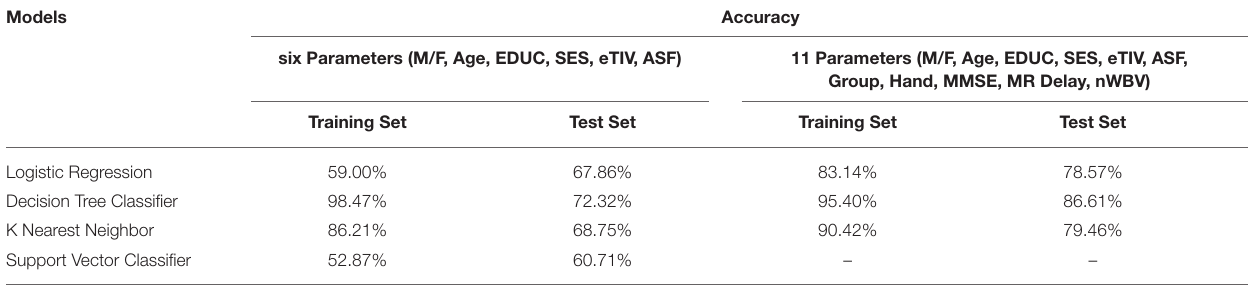
TABLE 1 | Accuracy obtained to predict AD in 2 years on the training and test sets. Models